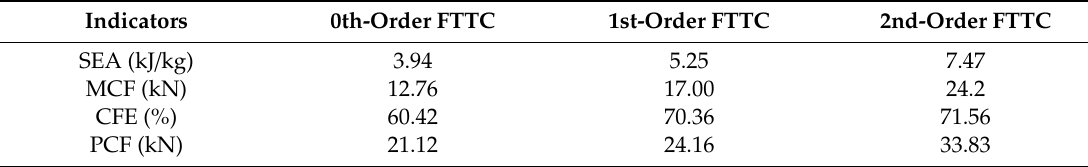
Table 6. Crashworthiness indicators of FTTC